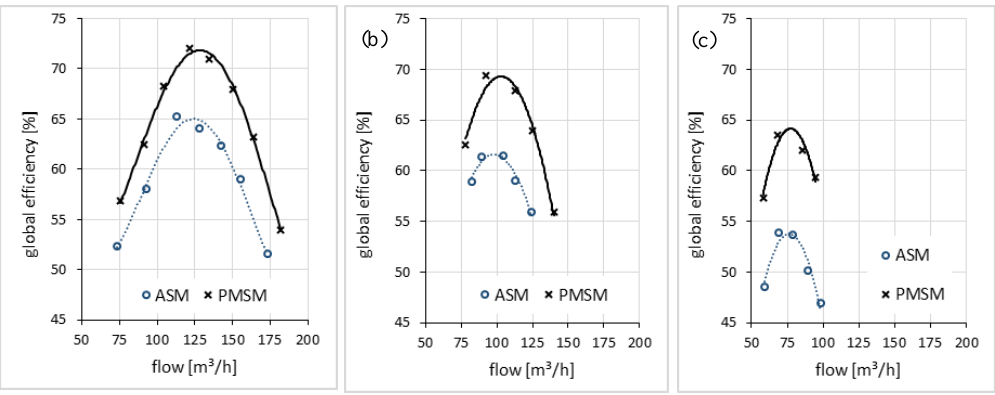
Figure 3. Global efficiencies of ASM and PMSM pumps at ( a ) 100%, ( b ) 80%, and ( c ) 60% speed. The highest global efficiency was measured at a maximum speed, with 65.2% for the ASM pump and 72.0% for the PMSM pump, resulting in a 6.8%-points higher efficiency for the latter (Figure 3a). At medium speed, the maximum ASM pump efficiency is 61.4% and 69.4% for the PMSM pump, respectively, resulting in a 8%-points higher global efficiency for the PMSM pump (Figure 3b). At a low speed, the maximum global ASM pump efficiency is 53.9% vs 63.5% for the PMSM pump (9.6%- points higher efficiency, Figure 3c).